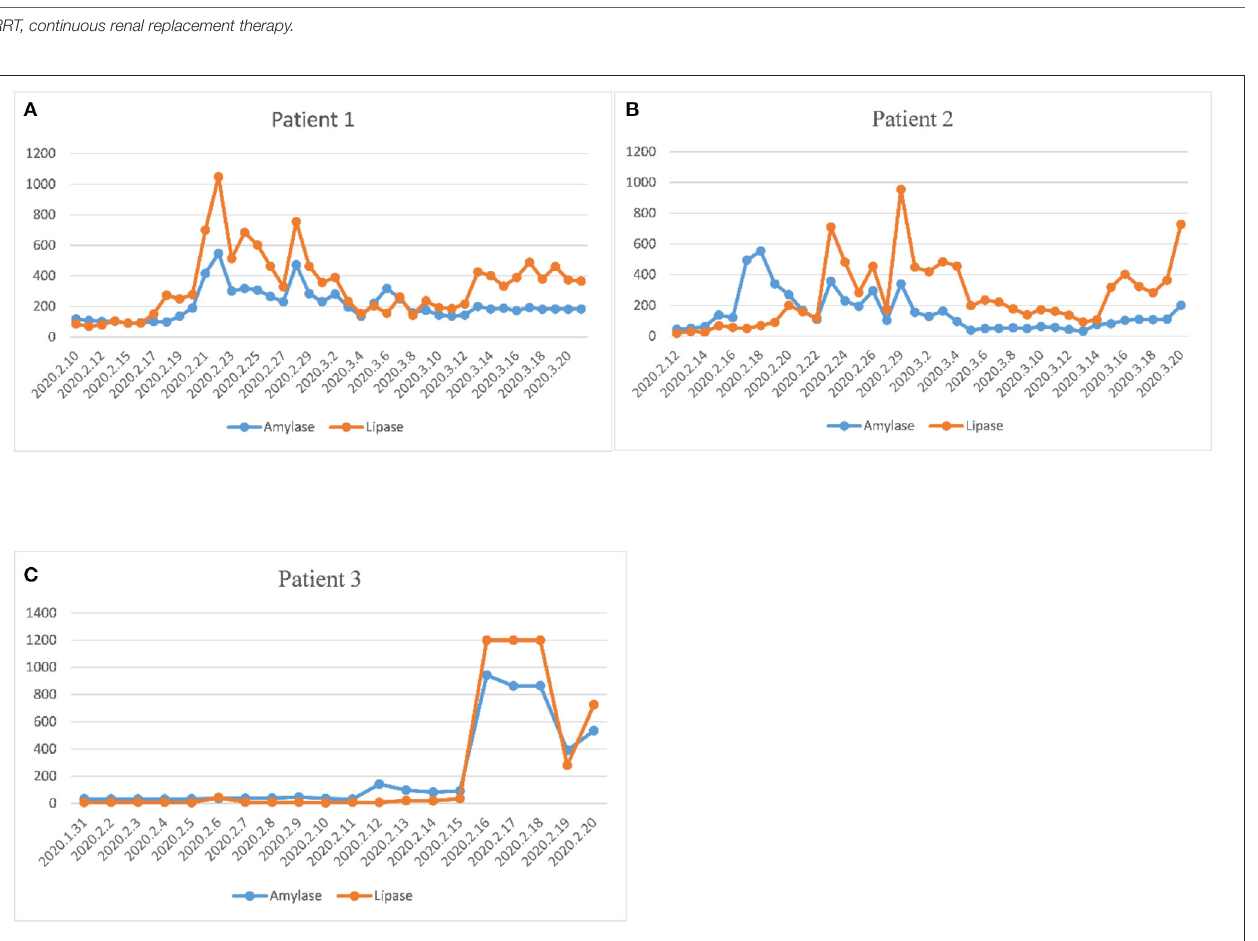
Patients of COVID-19 without elevated elevated enzymes ( N = 23) pancreatic enzymes ( N = 29)